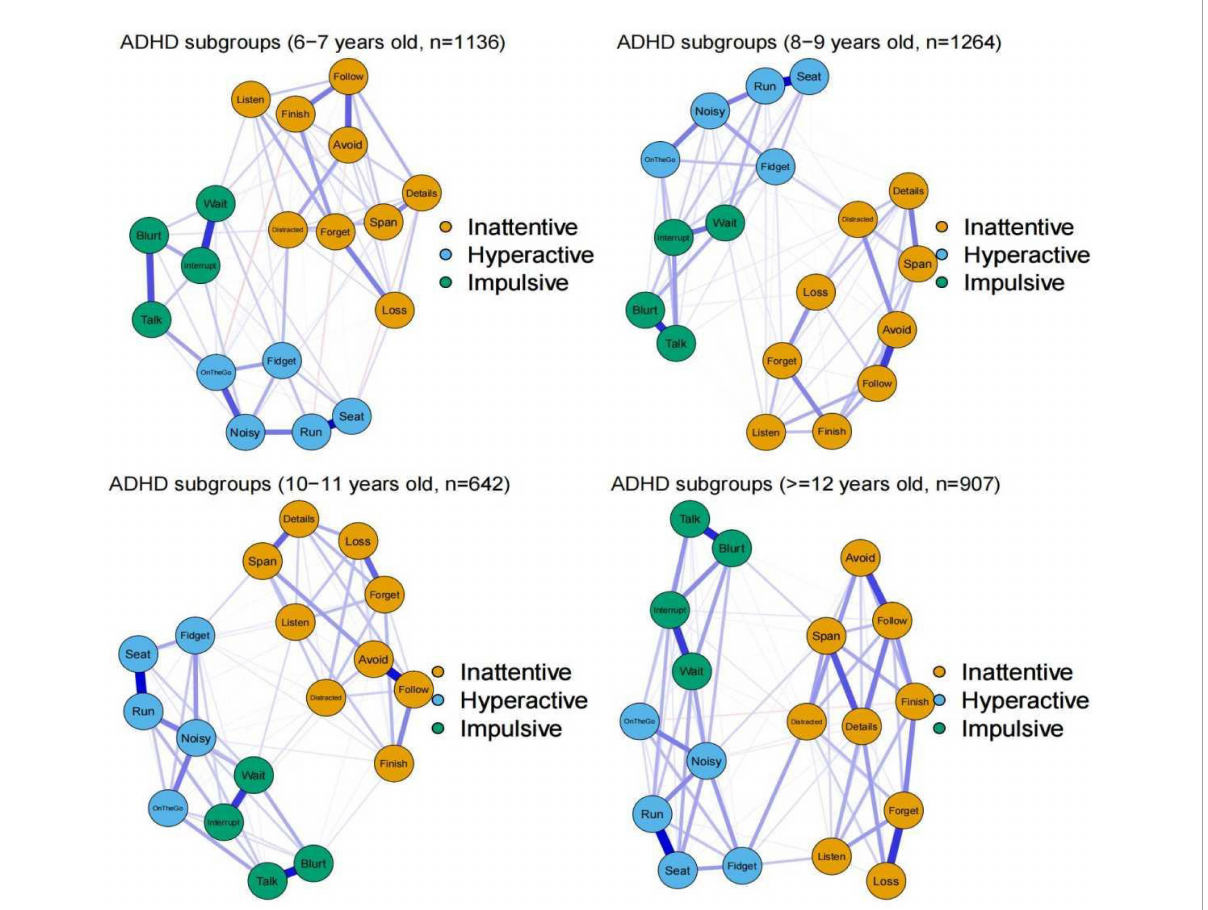
FIGURE5 The network structures in different age groups. The blue edges indicate positive partial correlations and edges in red indicates negative partial correlations. Thicker lines represent stronger connections.